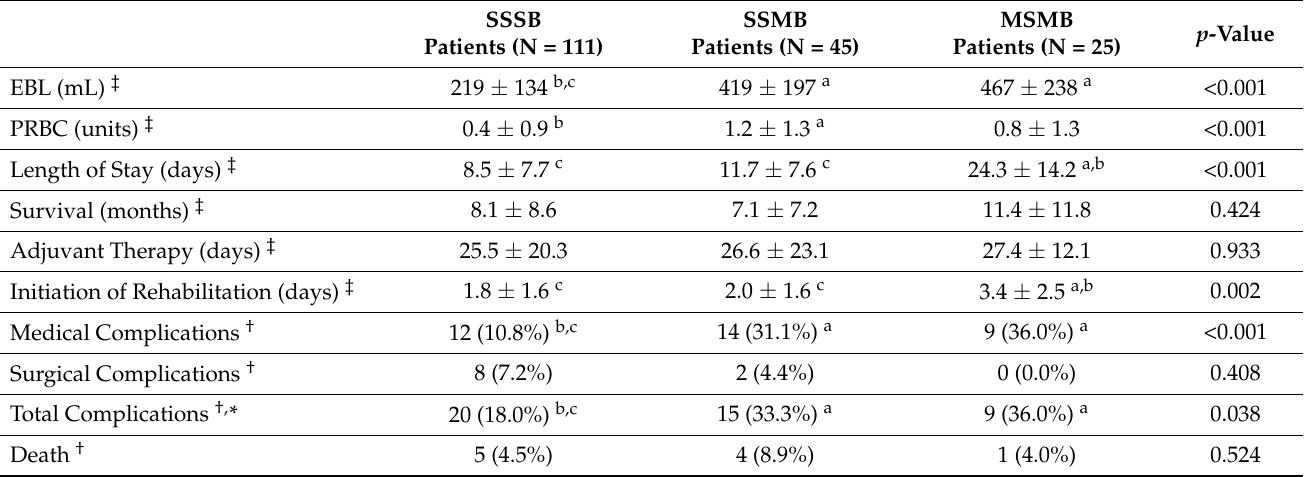
Table 3. Perioperative data of patients with metastatic long-bone disease who underwent in- tramedullary nail fixation in different study groups. SSSB Patients (N = 111)